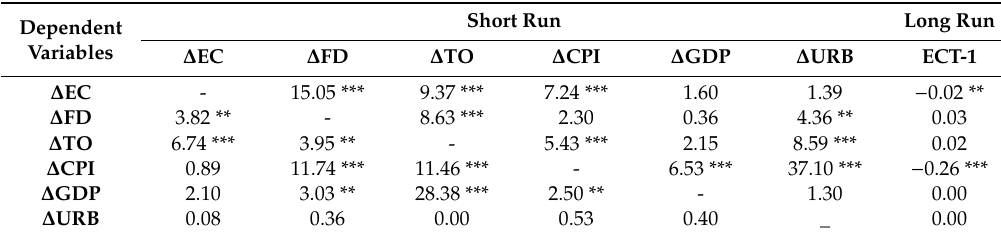
Table 6. Granger causality test results.